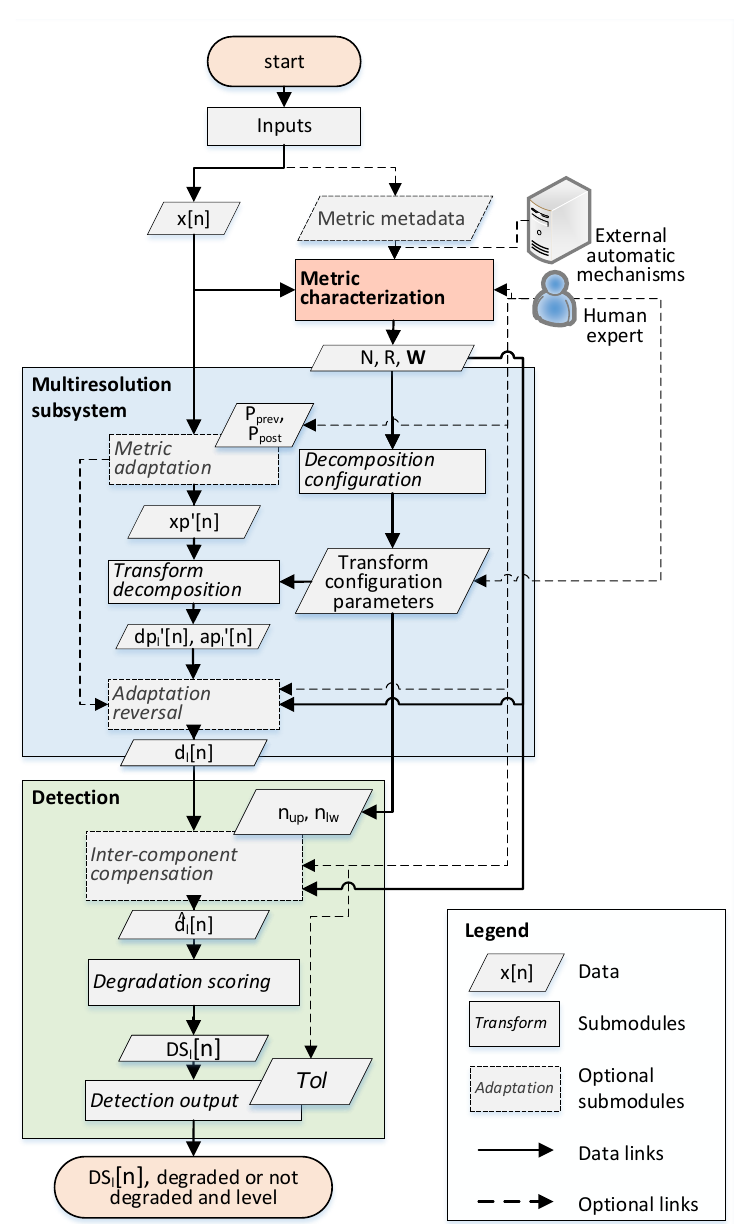
Figure 8. Steps of the multiresolution